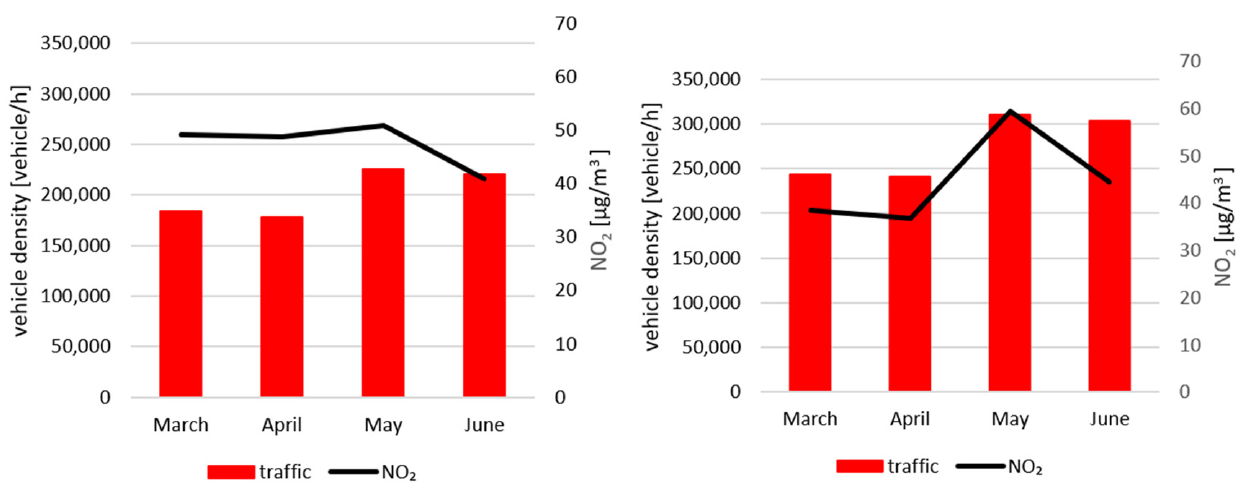
Figure 7. Comparison of the average number of trips generated with the mean NO 2 concentration, March–June 2020-al. Niepodleg ł o ś ci in Warsaw.